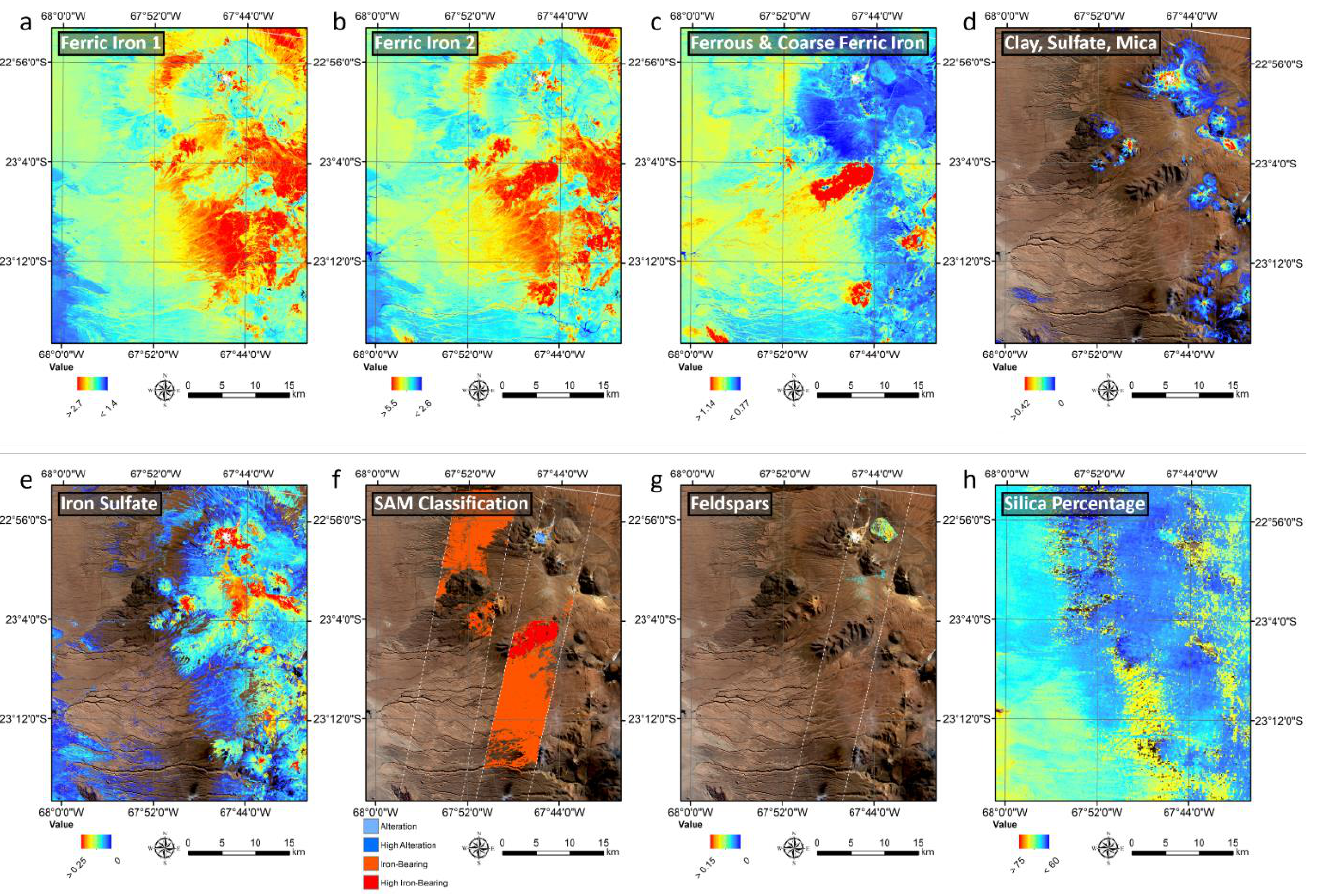
Figure 5. Maps of the region surrounding ALMA and Toconao Village (22 ◦ 53 (cid:48) 0 (cid:48)(cid:48) S, 28 ◦ 0 (cid:48) 0 (cid:48)(cid:48) W to 23 ◦ 18 (cid:48) 0 (cid:48)(cid:48) S, 67 ◦ 39 (cid:48) 0 (cid:48)(cid:48) W). ( a ) Landsat 8 OLI ferric iron 1 “redness” band ratio index. ( b ) Landsat 8 OLI ferric iron 2 band ratio index. ( c ) Landsat 8 OLI ferrous/coarse-ferric iron band ratio index. ( d ) Landsat 8 OLI clay-sulfate-mica band ratio index. ( e ) Landsat 8 OLI iron-sulfate band ratio index. ( f ) EO-1 Hyperion SAM classification result. “Alteration” and “High Alteration” groups are based on montmorillonite and alunite/kaolinite minerals, respectively. “Iron-Bearing” and “High-Iron- Bearing” groups are based on moderate hematite and high hematite/hornblende spectral signatures, respectively. ( g ) EO-1 Hyperion feldspar band depth index. ( h ) Estimated silica percentage from ASTER